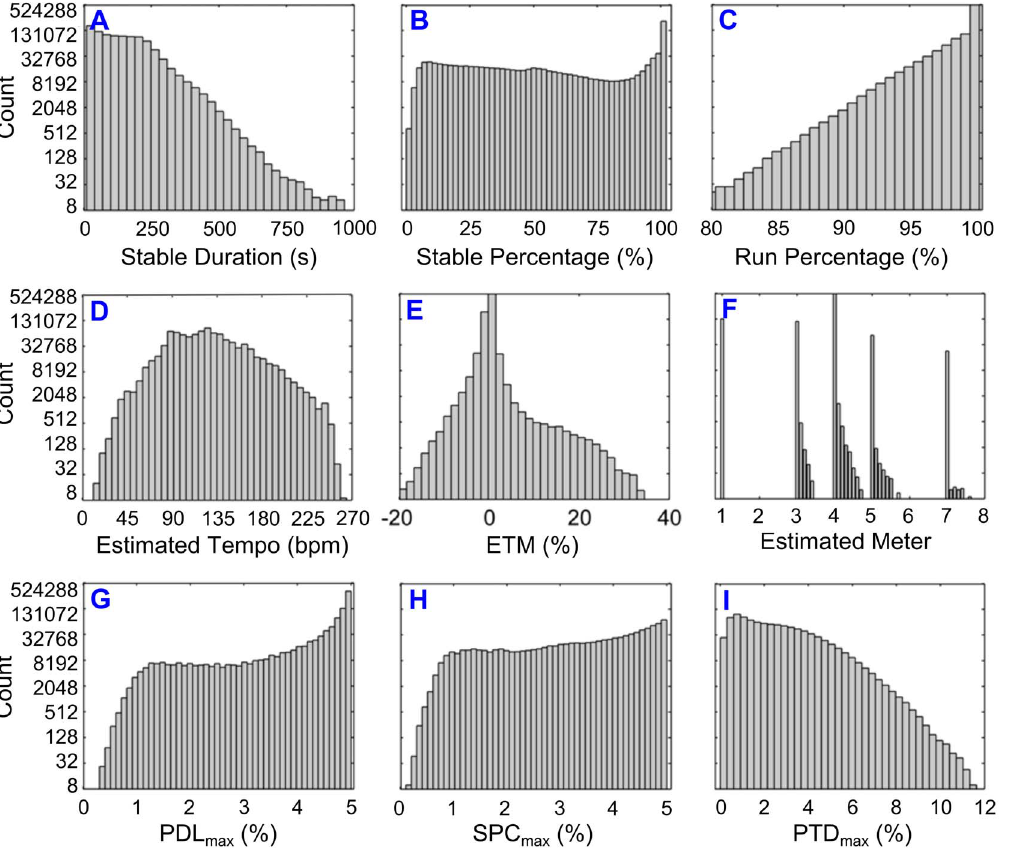
Figure 4. Histogram summaries of the nine Summary Statistics across the Million Song Dataset ( N 5 971,278), using log 2 scaling along the y -axis to enhance visibility. Labels ‘‘A’’ through ‘‘I’’ correspond to the order in which Summary Statistics were defined in Section E of the